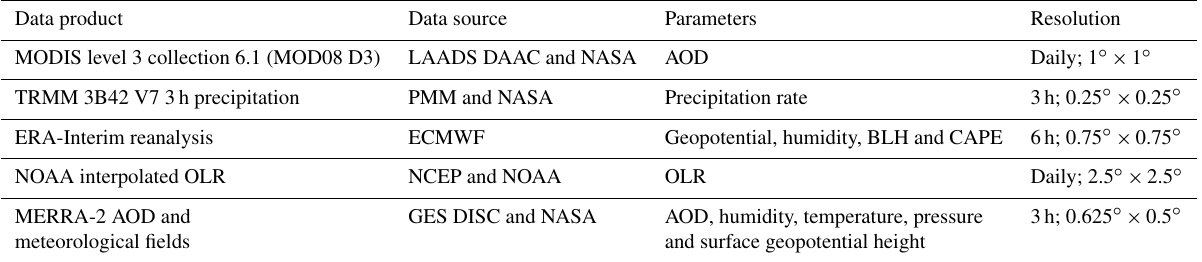
Table 1. Overview of the data sets used in this study. Note: LAADS – Level 1 Atmosphere Archive and Distribution System; DAAC – Distributed Active Archive Center; PMM – Precipitation Measurement Missions (of NASA); NCEP – National Centres for Environmental Prediction; GES DISC – Goddard Earth Sciences Data and Information Services